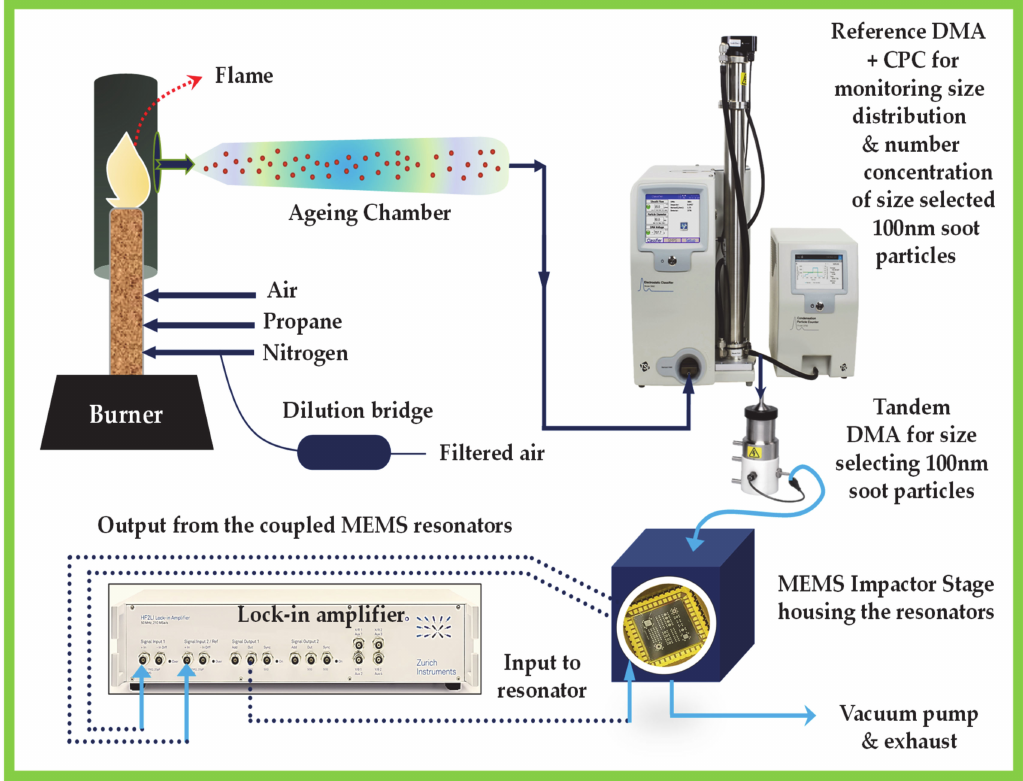
Figure 3. Experimental setup including soot particle generator, MEMS Impactor Stage housing the resonators and associated electronics; DMA stands for Di ff erential Mobility Analyser and CPC stands for Condensation Particle